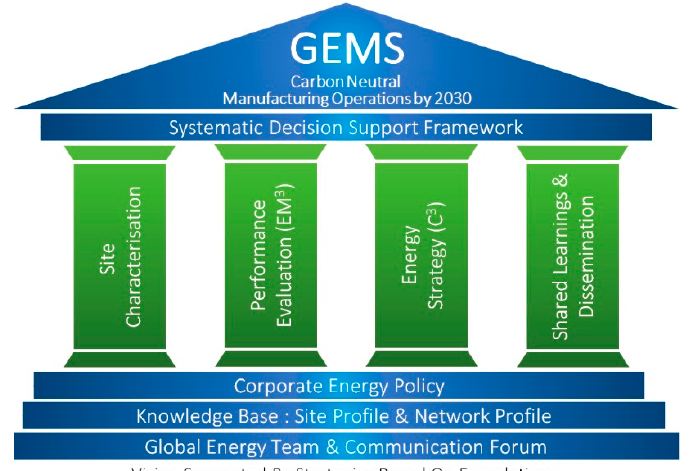
Figure 1. BSC GEMS